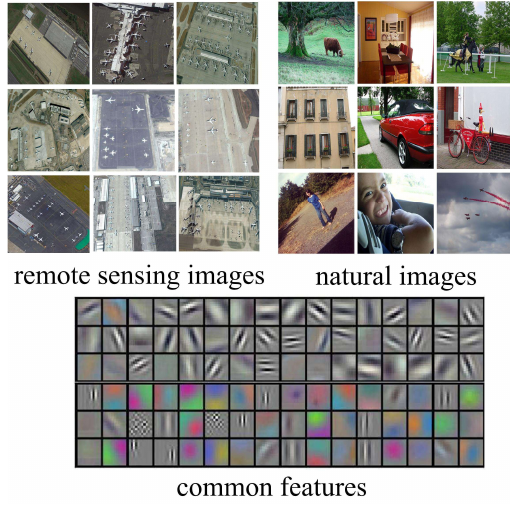
Figure 10. Transfer learning.